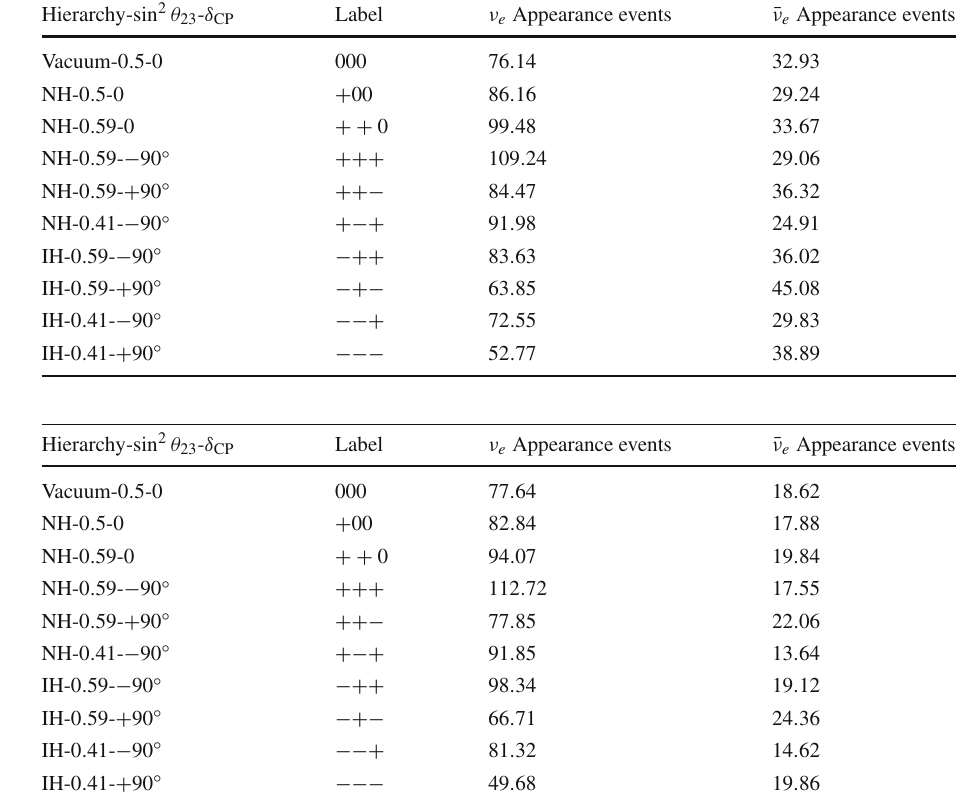
Table 3 Expected ν e and ¯ ν